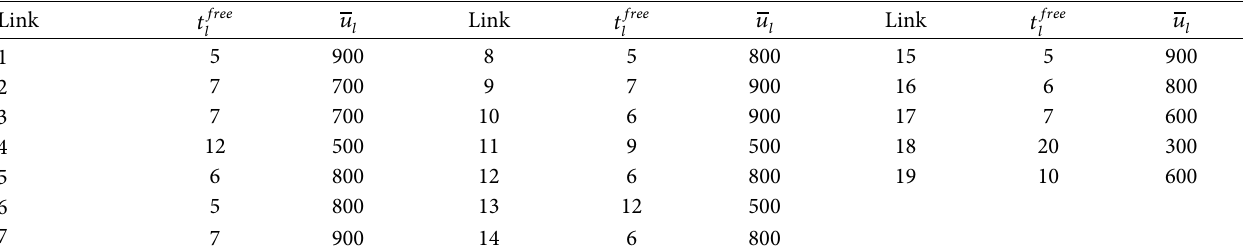
Figure 2: Nguyen–Dupuis network. Table 1: Network characteristics.